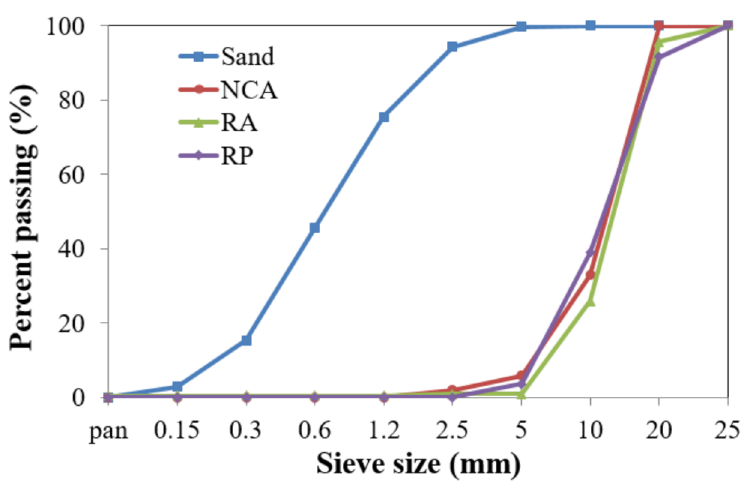
Figure 2. Aggregate gradation for RP, natural coarse aggregate (NCA), and fine aggregate